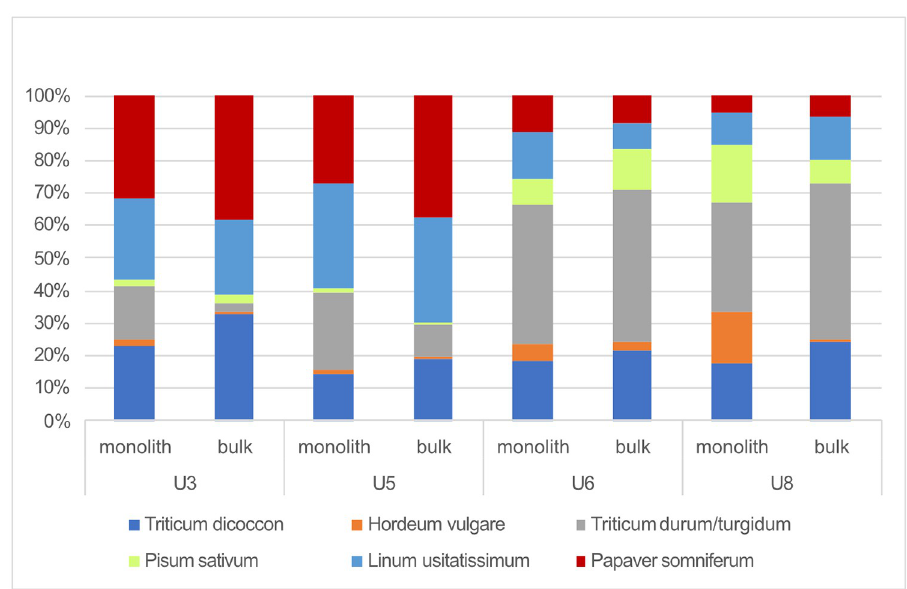
Fig 12. Caloric input from cultivated